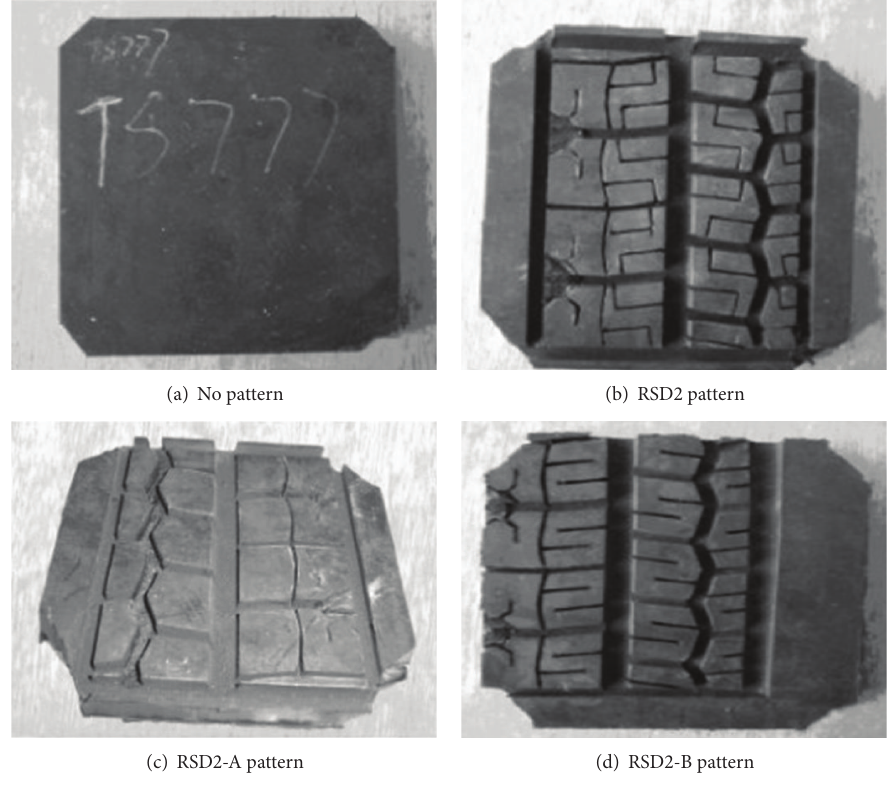
Figure 1: Rubber samples.